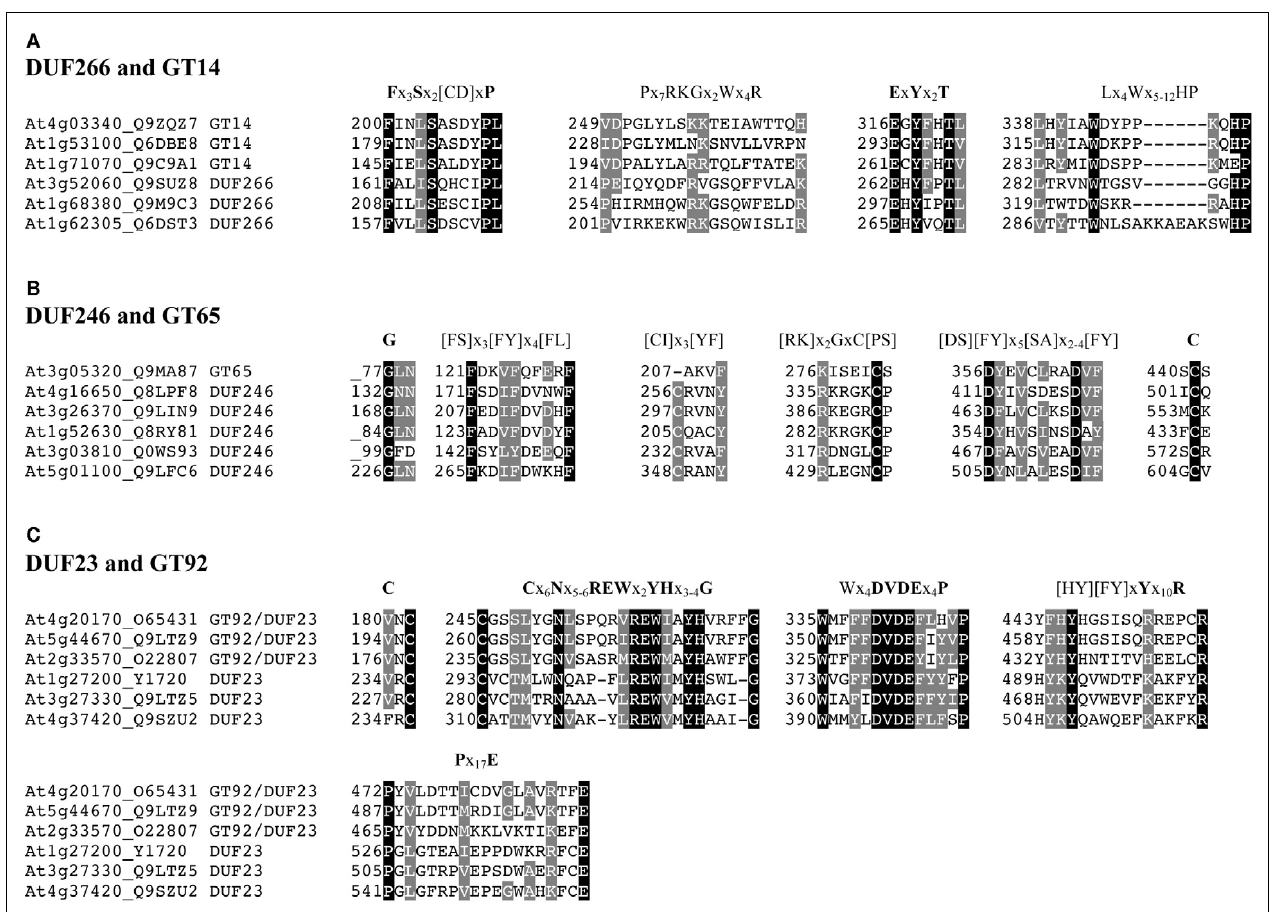
conserved positions are shaded in gray. Dashes indicate gaps. Numbers indicate the amino acid position of the first residue of each motif. Schematic illustration of conserved motifs for (A) DUF266 and GT14, (B) DUF246 and GT65, and (C) DUF23, based on non-redundant Arabidopsis sequences are shown above each alignment. Strictly conserved residues are in bold and residues with only two alternative amino acids are denoted by